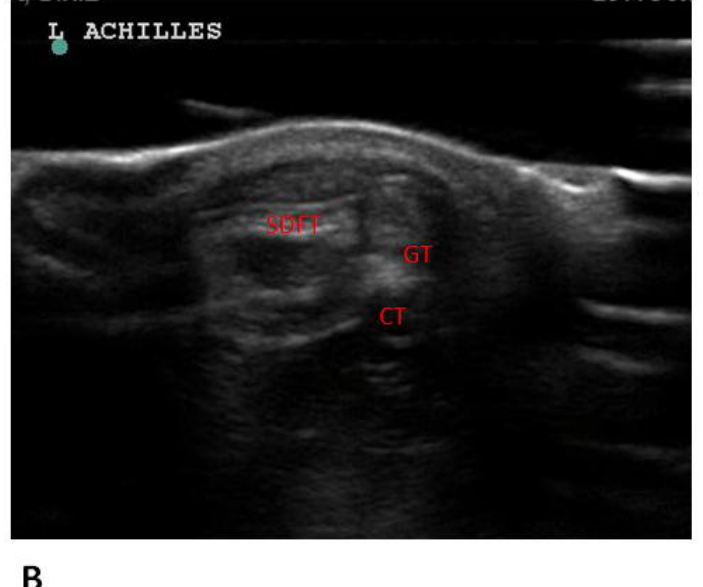
Figure 6B : Cross-sectional view of a normal Achilles tendon - proximal In cross-sectional view, the appearance of the 3 components of the Achilles tendon remains virtually unchanged in the proximal and middle parts of the